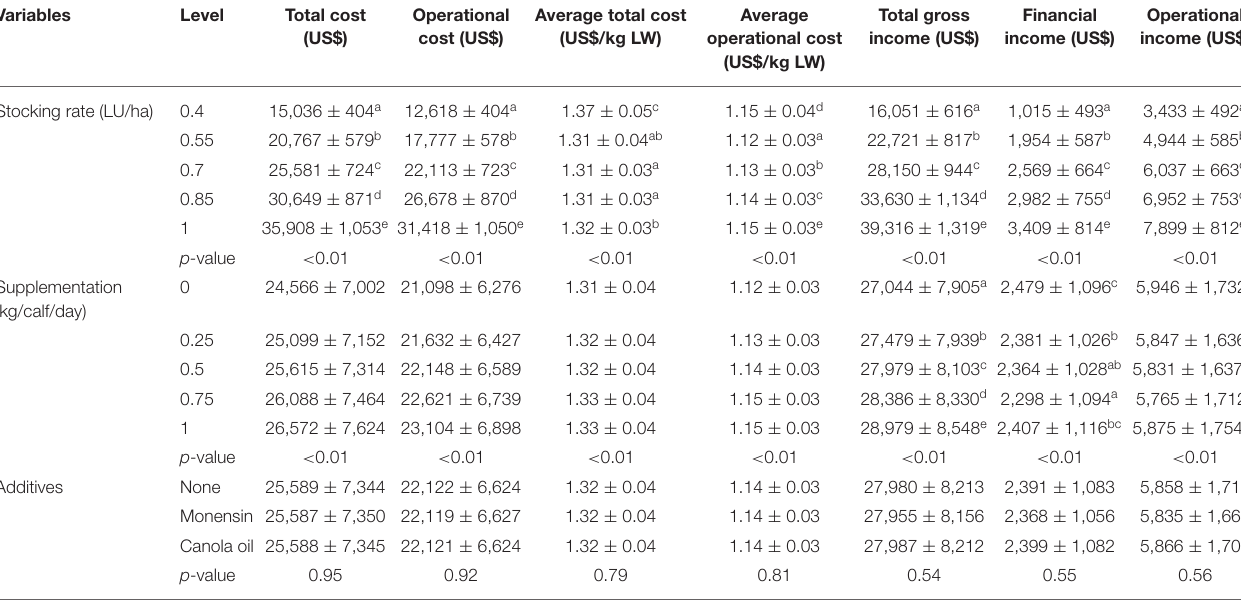
TABLE 5 | Cost and income variables concerning supplementation and additives in the simulated scenarios.